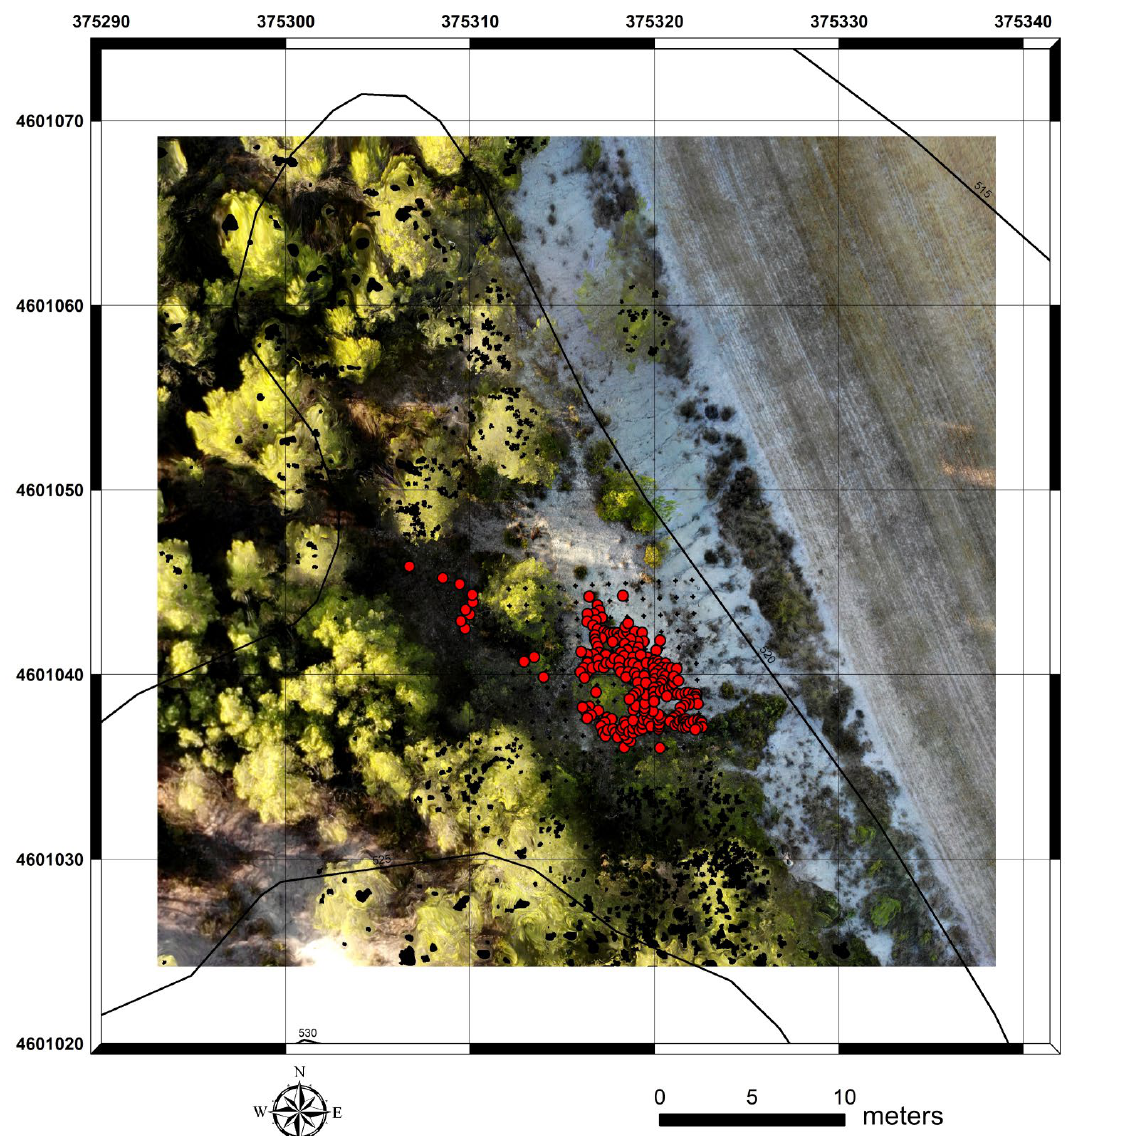
Figure 6. Orthoimage of the Guinardera Nord Workshop, obtained with a Dji Maverick drone. The figure also illustrates the area involved and the dispersion of the registered materials (red dots with the circle in